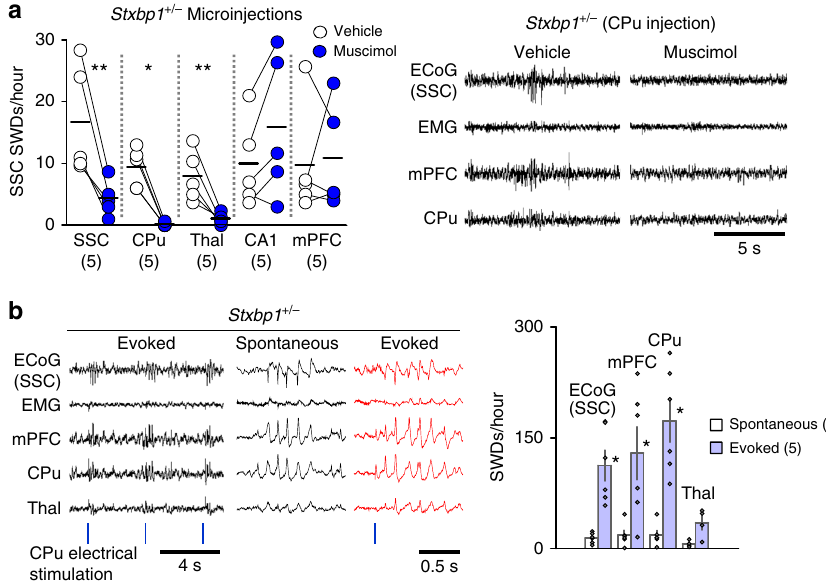
Fig. 2 Inactivation of CPu, SSC and thalamus (Thal) suppresses SWDs and activation of CPu induces SWDs in Stxbp1 + / − mice. a Muscimol injections in Stxbp1 + / − mice. (Left) Injections into SSC, CPu, Thal but not in CA1 and mPFC suppressed SWDs in SSC ECoG recordings (3 h recording after injection). SSC injection ( N = 5), CPu injection ( N = 5), Thal injection ( N = 5), CA1 injection ( N = 5), mPFC injection ( N = 5). Mann – Whitney U test, vehicle vs. muscimol, SSC: ** P = 0.0079; CPu: * P = 0.0119; Thal: ** P = 0.0079; CA1, P = 0.5476, mPFC P = 0.9166. Numbers of mice are shown in parentheses. (Right) Representative recordings in the mice with CPu injection. SWDs were suppressed in SSC, mPFC and CPu recordings. b Single brief electrical stimulation of the CPu evoked SWDs in Stxbp1 + / − mice. (Left) Representative recordings. (Right) Regional occurrence of spontaneous and evoked SWDs (6 experiments from 5 mice, 1 h recording). Mann – Whitney U test, spontaneous SWDs vs. evoked SWDs, SSC: ** P = 0.0022; mPFC: * P = 0.0152; CPu: ** P = 0.0022; Thal: P = 0.0571. Mean± SEM. * P < 0.05, ** P <